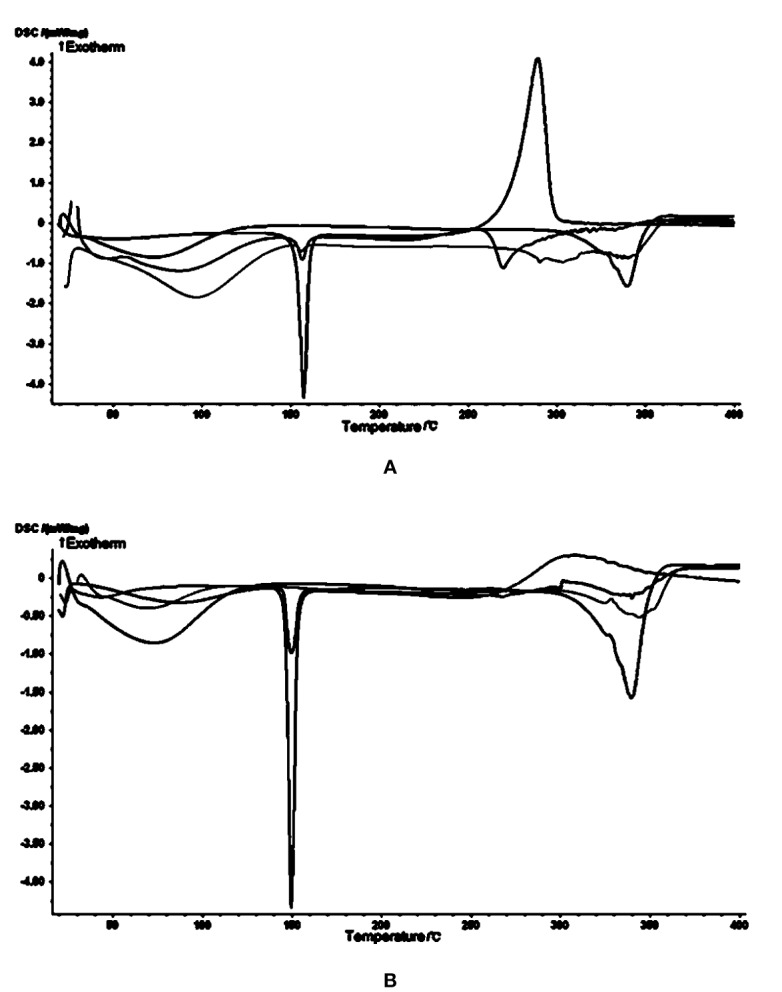
Images from the differential scanning calorimetry (DSC) analysis. Green line: hydroxypropyl-β-cyclodextrin (HP-β-CD); blue line: styryllactone only; brown line: physical mixture; pink line: complexes of HP-β-CD with (A) cheliensisin A and (B) gonidiol-7-monoacetate.